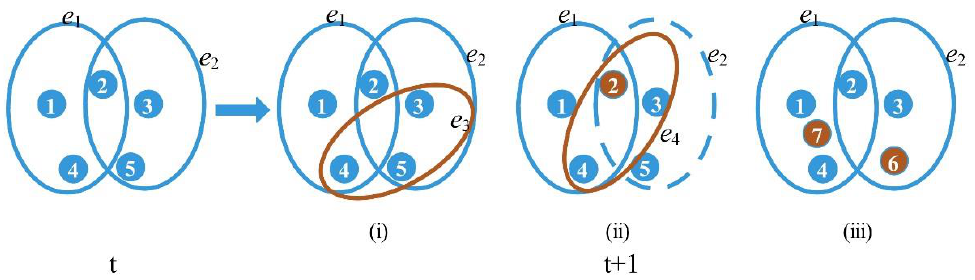
e consisting of nodes 3, 4, 3